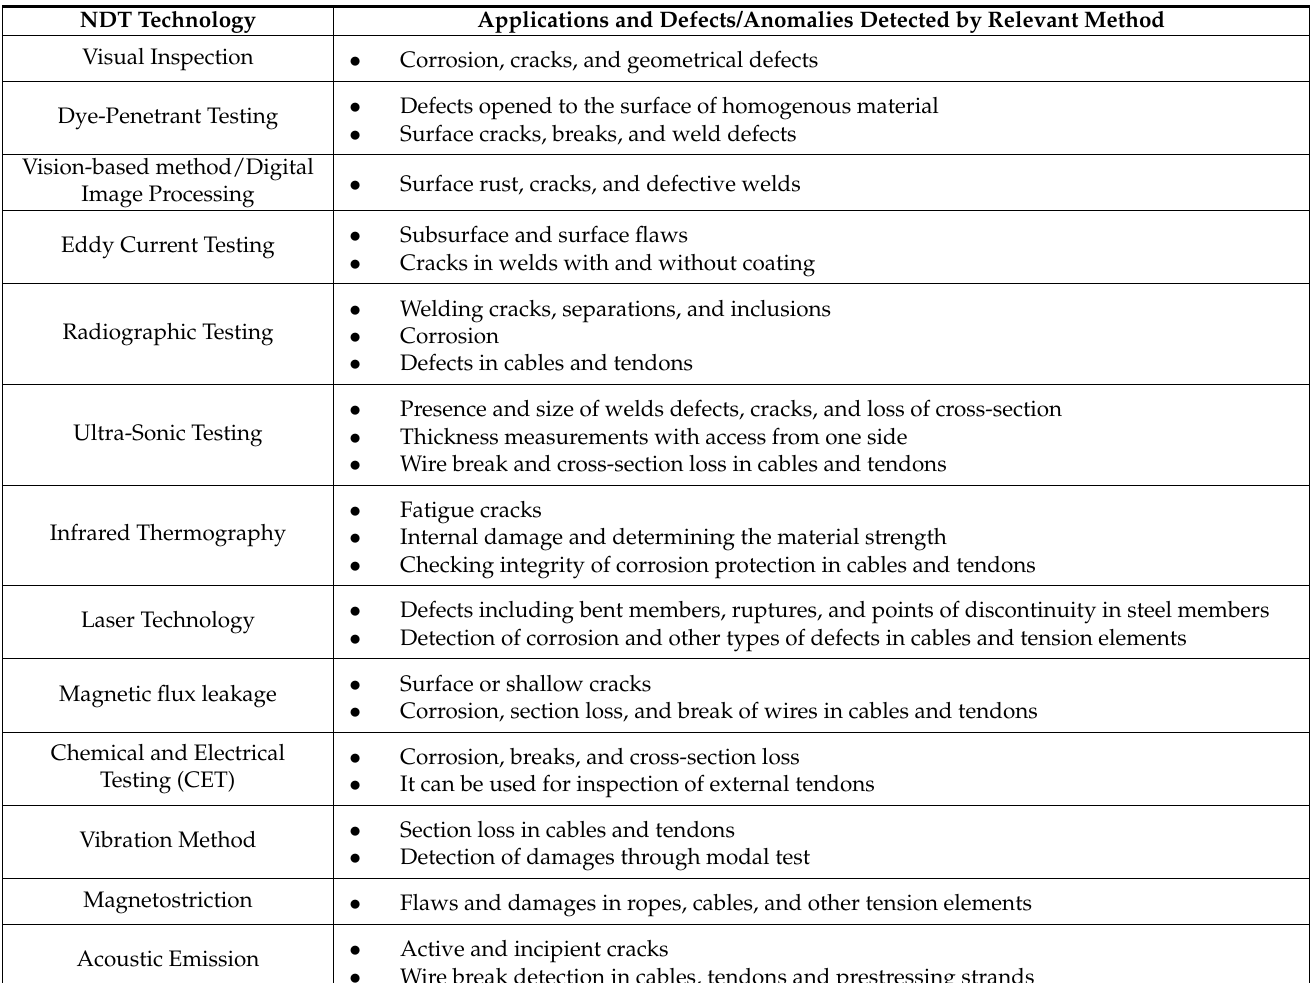
Table 2. The applications of NDT methods discussed in this study for steel bridges. Applications and Defects/Anomalies Detected by Relevant